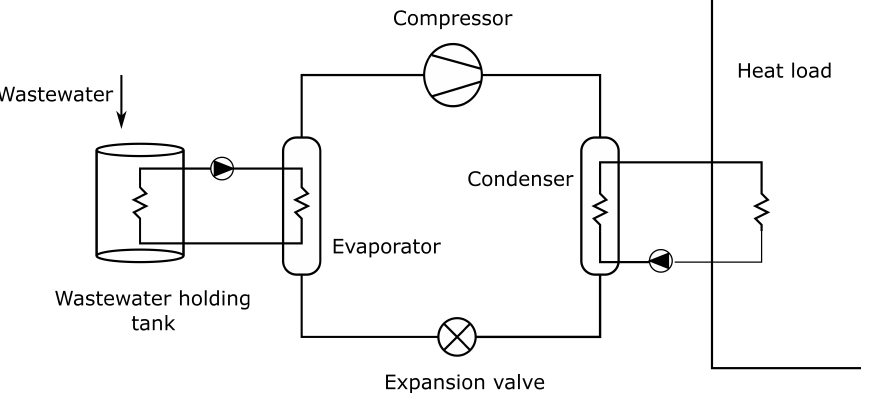
Figure 4. Schematic diagram of WWHR with heat